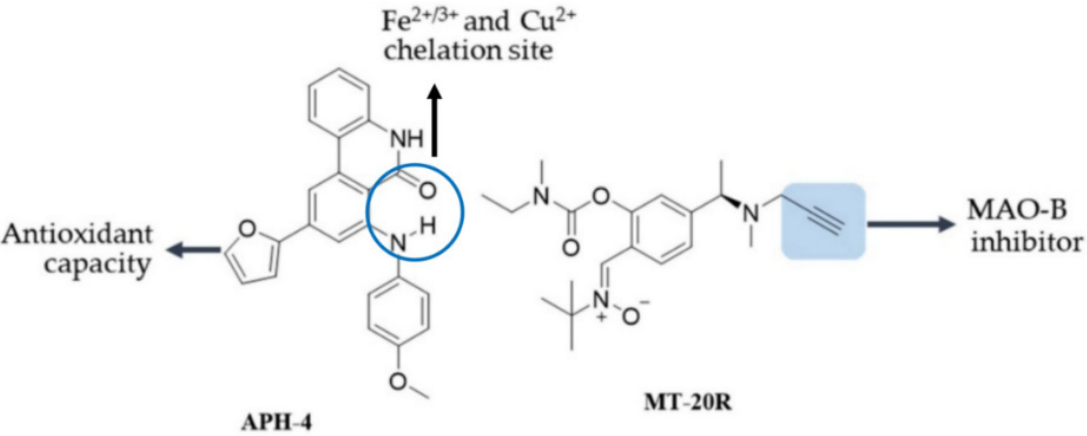
Figure 9. Chemical cores in APH-4 and MT-20R with neuroprotective activity . The APH-4 com- pound has anti-oxidant and metal chelating capacity; the latter not specified; In MT-20R the blue box shows the inhibition site for MAO-B.